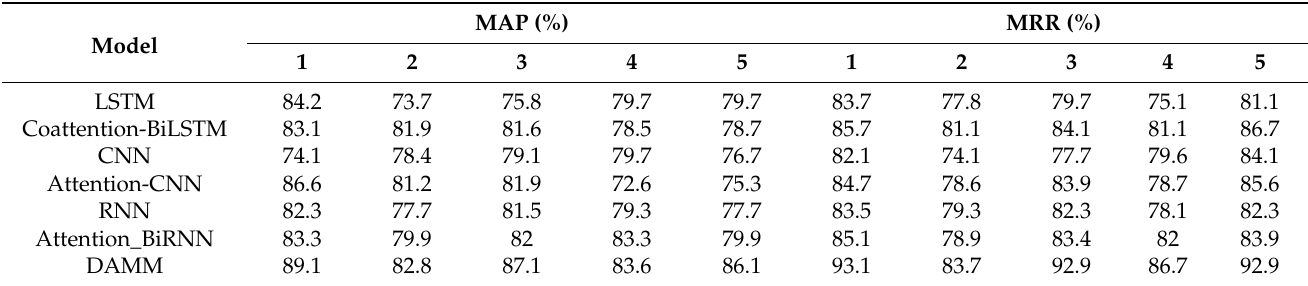
Table 4. Effect of different models on rice-related answer selection dataset.